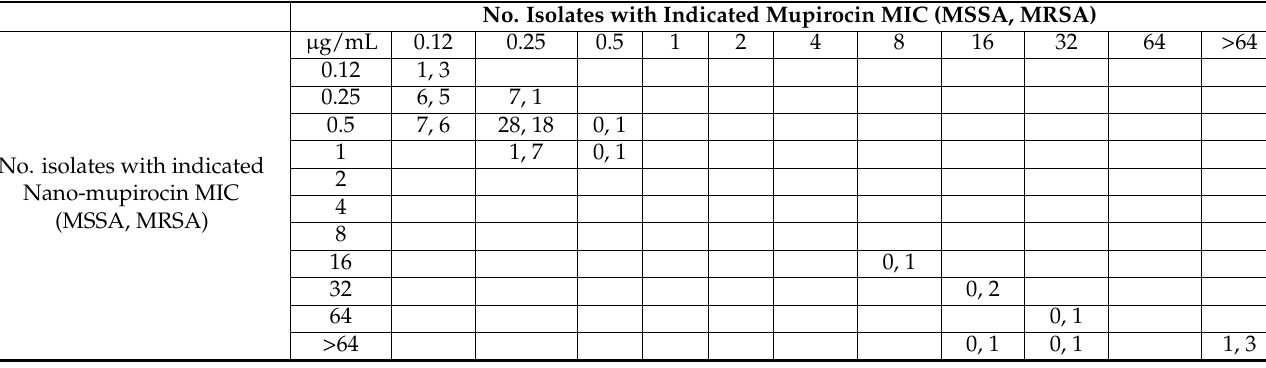
Table 1. Mupirocin and Nano-mupirocin MICs for methicillin-susceptible Staphylococcus aureus (MSSA) and methicillin- resistant Staphylococcus aureus (MRSA) isolates.